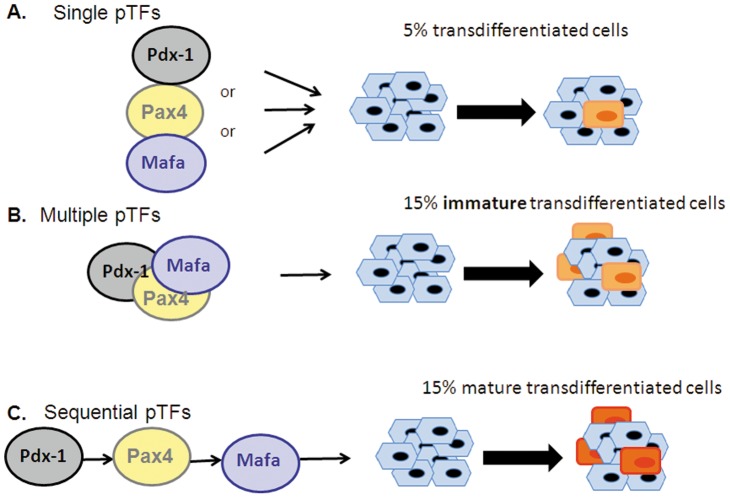
Schematic representation of the proposed sequential and hierarchical control of multiple pancreatic transcription factors (pTFs) induced liver to pancreas transdifferentiation.Liver to pancreas transdifferentiation is a fast and sequential process which is temporally controlled in a hierarchical manner. Three transcription factors promote the transdifferentiation efficiency such that many more cells produce pancreatic hormones (B compared to A). However, to increase both transdifferentiation efficiency and the cells maturation along the β cell lineage (maturation means pro-insulin processing and its glucose regulated secretion), the 3 pTFs which control distinct stages of pancreas organogenesis should be sequentially supplied in a direct hierarchical mode (C).